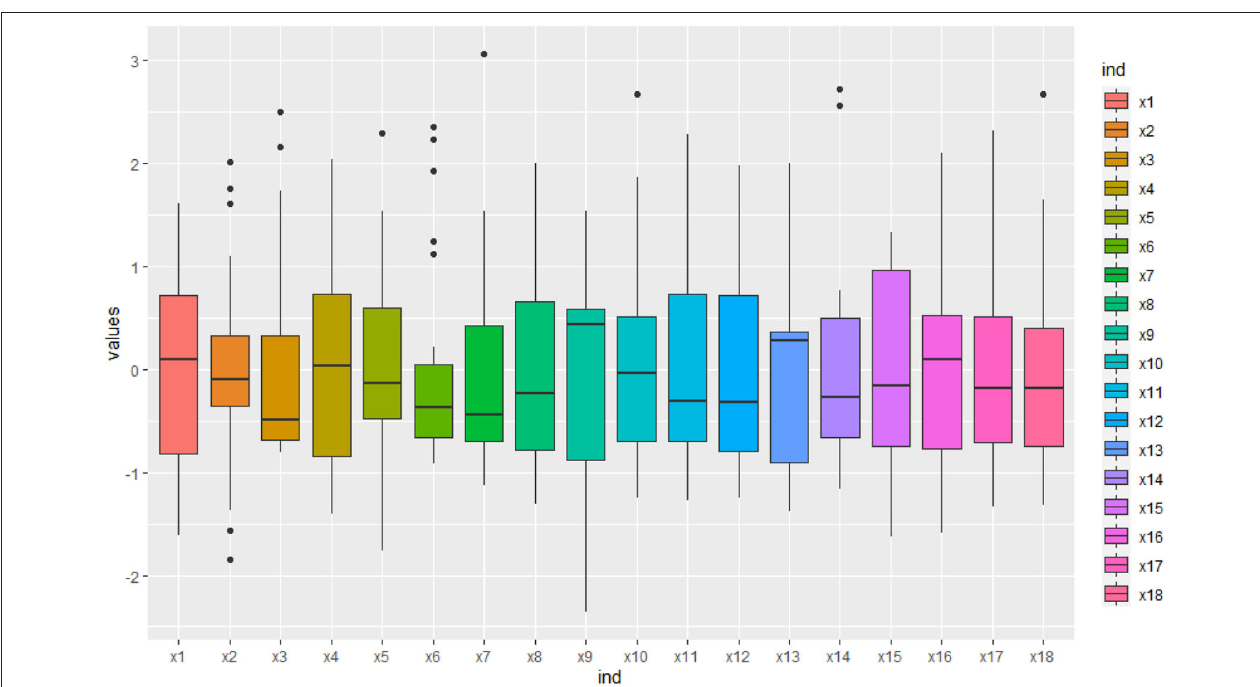
FIGURE 2 | The box line diagram of the physiological/biochemical indicators. The blue curve is the regression curve, the shaded part indicates the confidence interval, and the larger the shaded area the worse the regression effect of the curve. It shows that some physiological/biochemical indicators lack consensus in the biomass accumulation of S.miltiorrhiza .